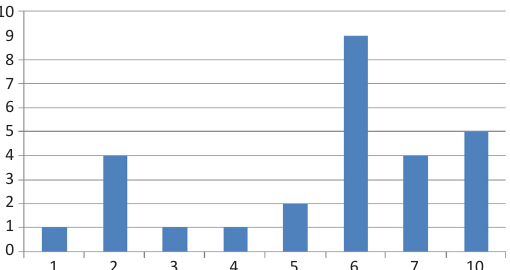
Figure 4. Dehydration, illness and visceral gout—live rescued by month Figure 5. Dehydration, visceral gout and illness—dead encountered